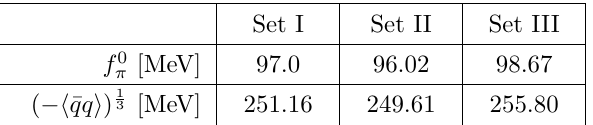
( p 2 ) and σ ( p 2 ) inside the parabola. v s ± ±